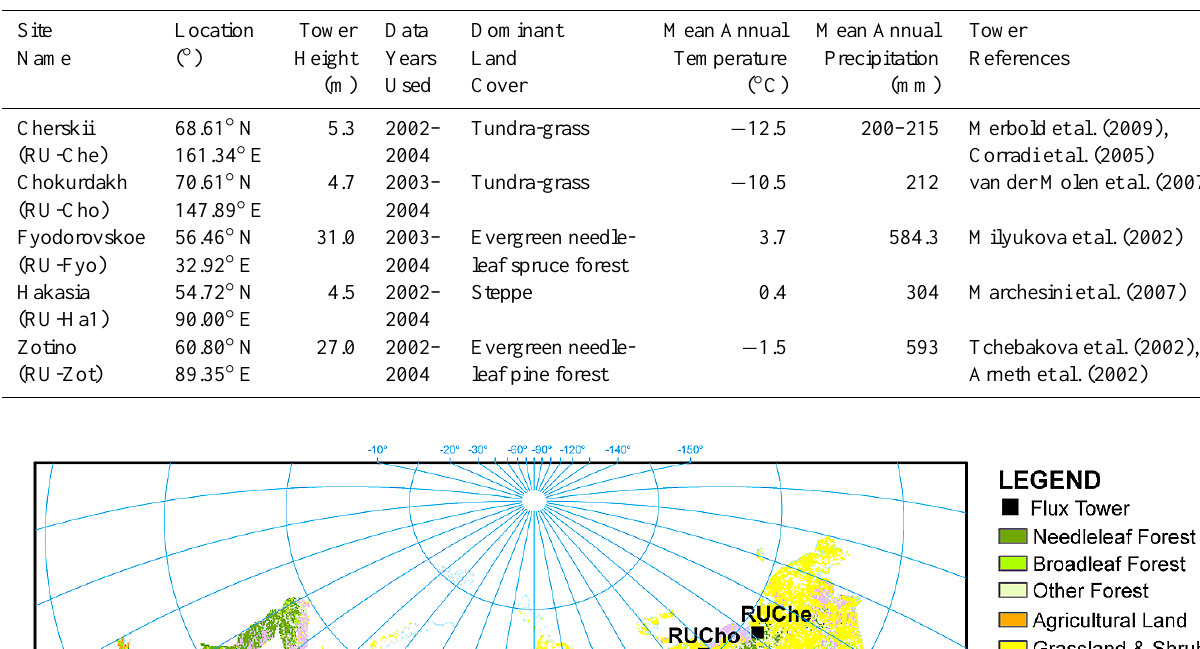
Table 2. A description of the five flux towers used in this study.